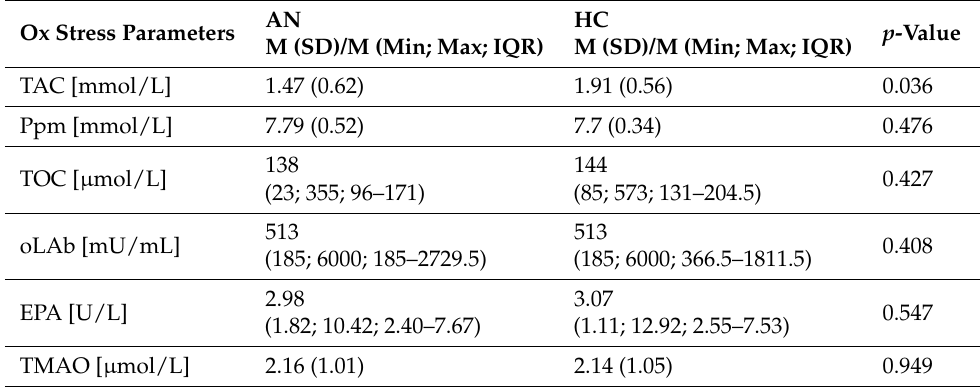
Table 3. Oxidative stress biomarkers. AN = anorexia nervosa, HC = healthy controls, M = mean, SD = standard deviation, Min = minimum, Max = maximum, IQR = interquartile rank, TAC = total an- tioxidant capacity, PPm = Polyphenols microtitre, TOC = total oxidative capacity, oLAb = Antibodies against oxidized low-density lipoproteins, EPA = endogenous peroxidase activity, TMAO = trimethy- lamine